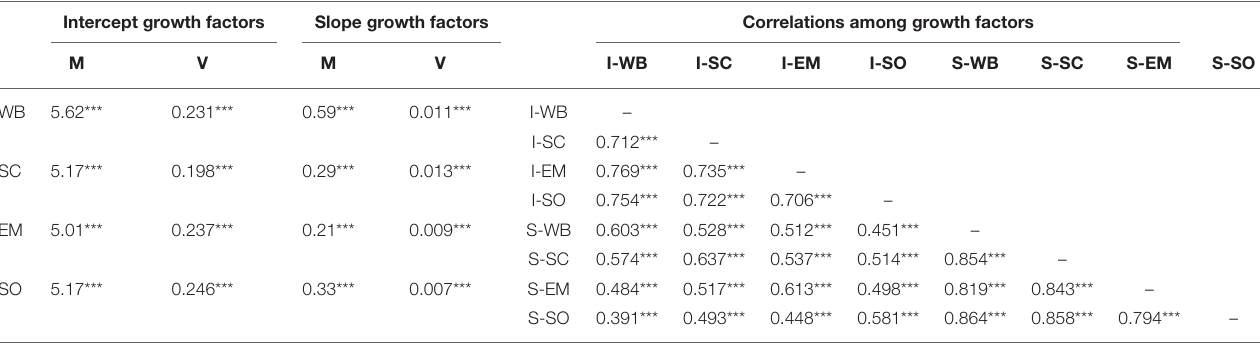
TABLE 4 | Results of the parallel process model (PPM). Intercept growth factors